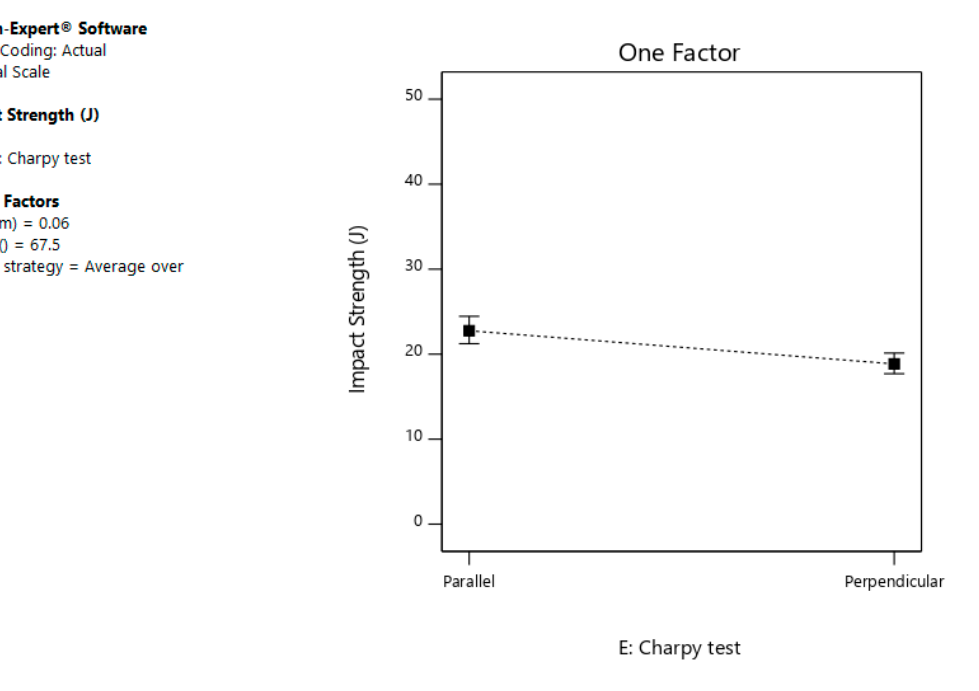
Figure 5. Variation of impact strength with the direction of impact relative to the build direction.